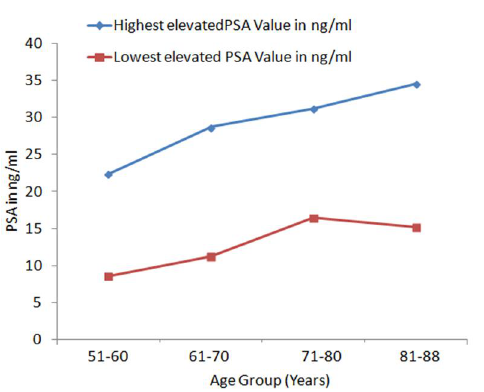
Figure 1. The elevated mean PSA level in different age group of patients PSA was estimated in the blood samples of patients of different age group by CLIA. Each bar represents Mean±SD of the elevated PSA level of different patients in respective age groups. Statistical significance was compared with Normal limit by student t test. ****p =0.001; ***p = 0.005, **p =0.02, *p =0.01. [The data of 37 patients in (51- 60), 51 patients in (61-70), 42 patients in (71-80) and 48 patients in (81-88) age group is shown as Mean±SD].